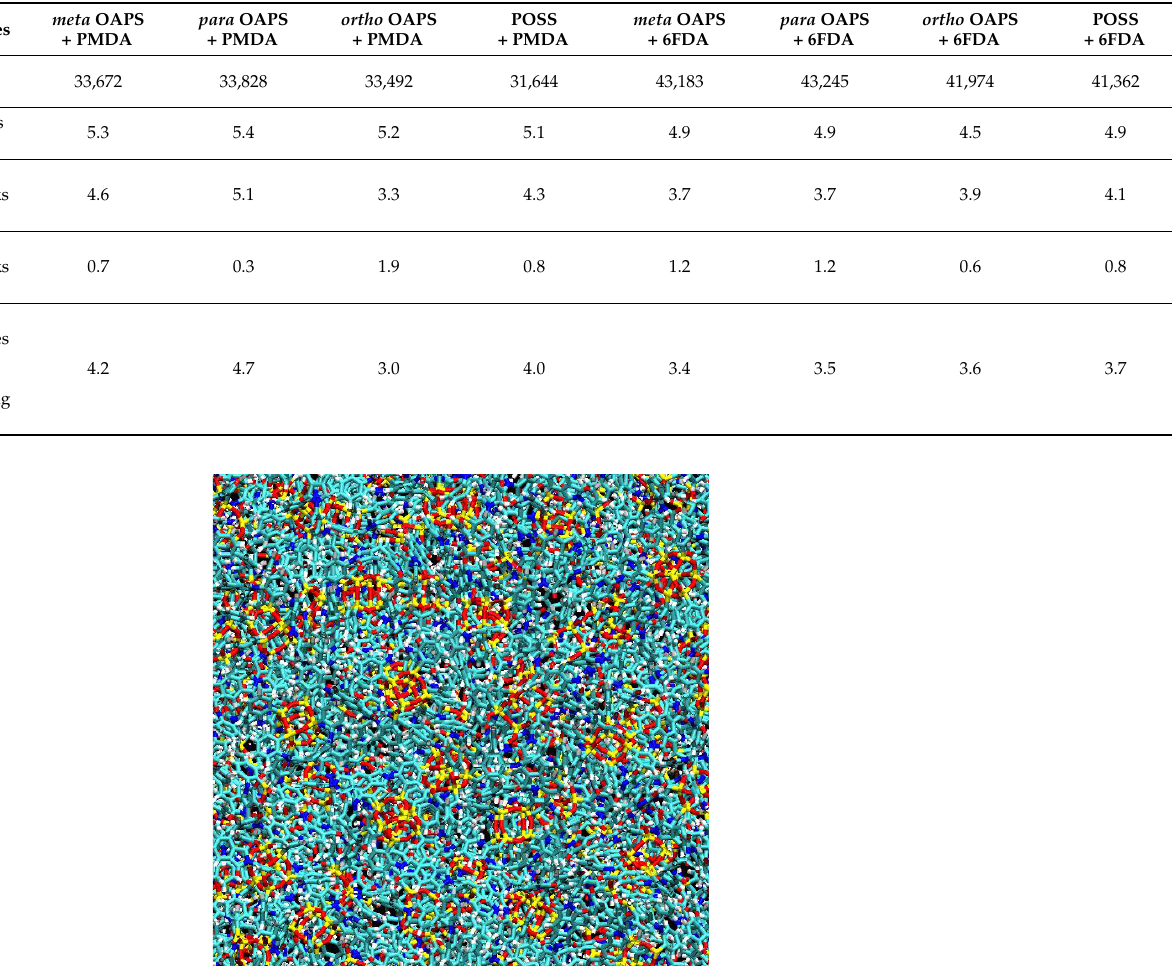
Table 1. Connectivities of the polyOAPS/POSS-imide network models. More details are provided in Refs [59,60].